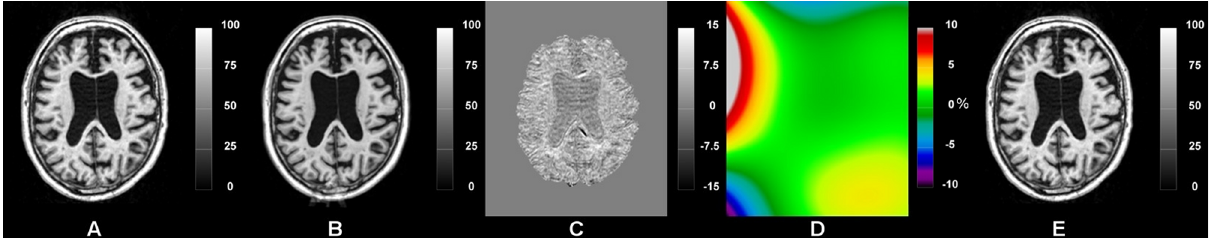
Fig 4. Individual longitudinal template-based bias field correction of an AD subject from the ADNI database. From left to right: A) baseline time-point, B) individual linear template, C) baseline time-point and individual template intensity difference image (or A-B), D) bias field of the difference image (C) and E) the baseline image after correction of the longitudinal bias field (D). (Note the different ranges on the color